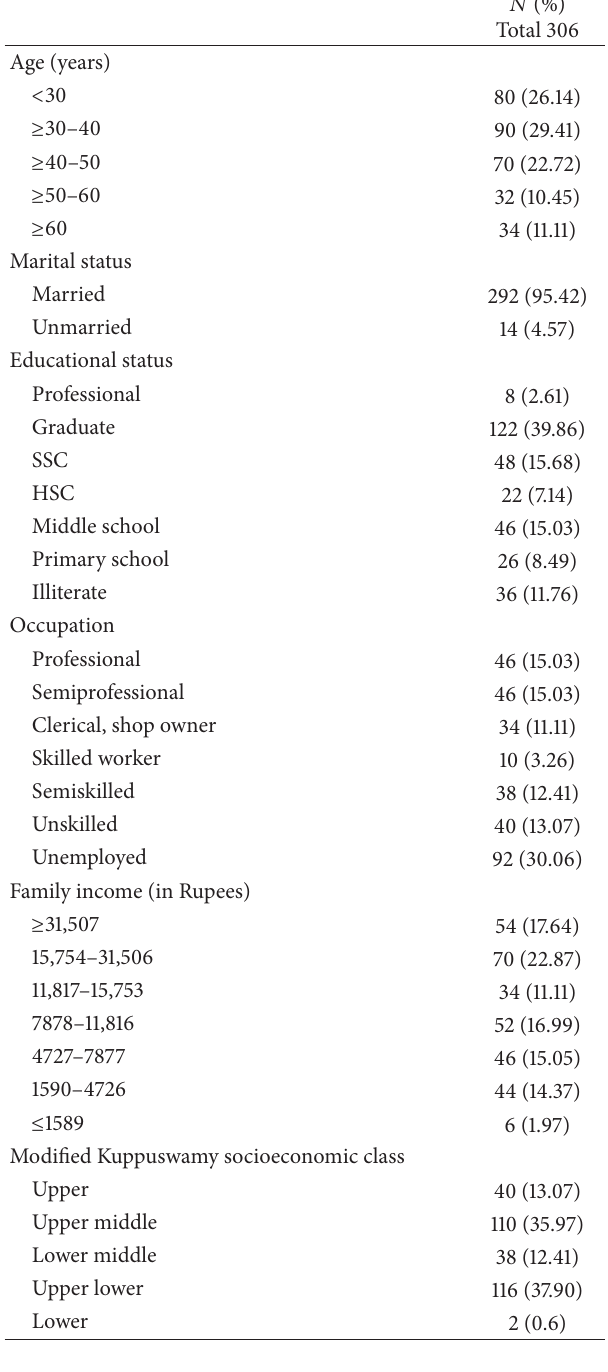
Table 1: Demographic date of participants of the